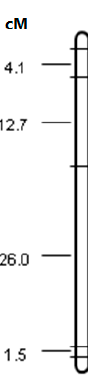
Figure 3. PCR amplification of Ora12 ( A ); TOP1017 ( B ); Xgwm18 ( C ); Xgwm498 ( D ); and Xwe173 ( E ) separated by agarose ( A , B , E ) and silver-stained polyacrylamide gels ( C , D ).